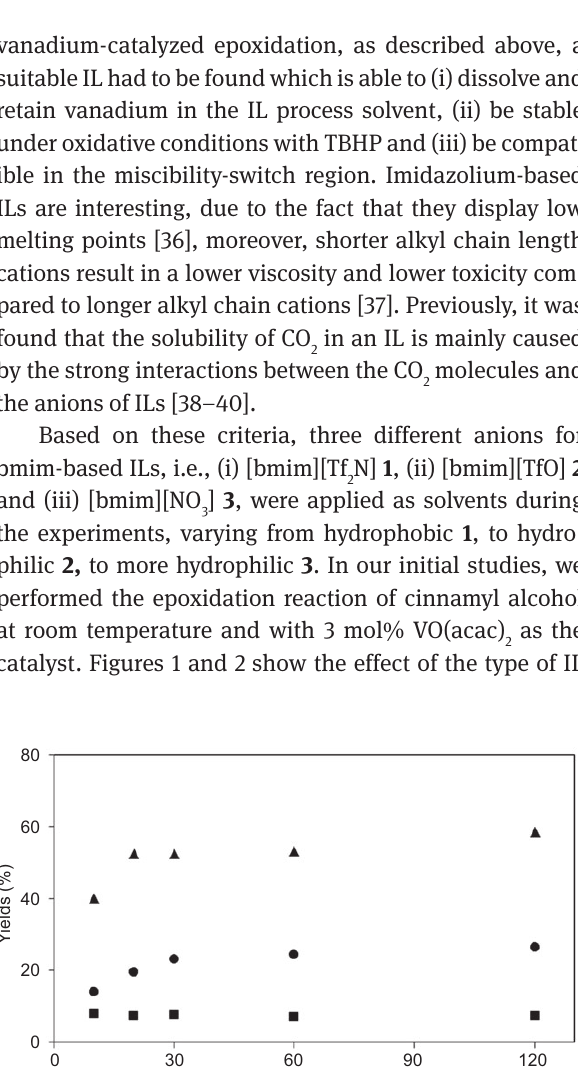
, 1.5 equiv. TBHP, 25 ° C]: 2 ]. 3